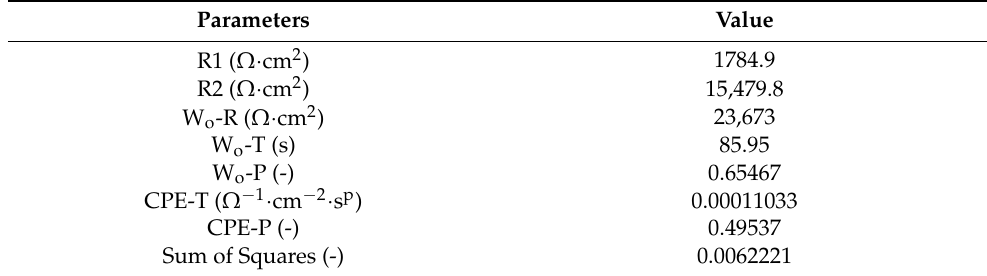
Table A1. Parameters of the fit of the Reference Group.